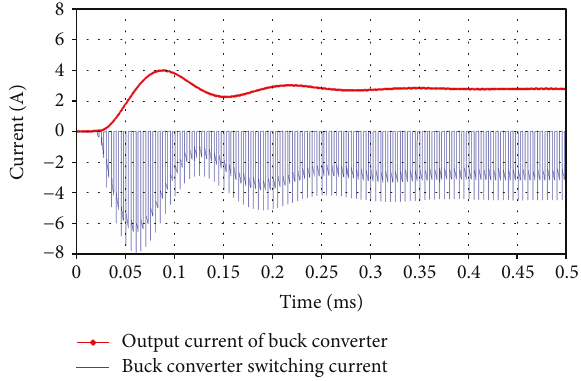
Figure 13: Input and output current waveforms for 61V